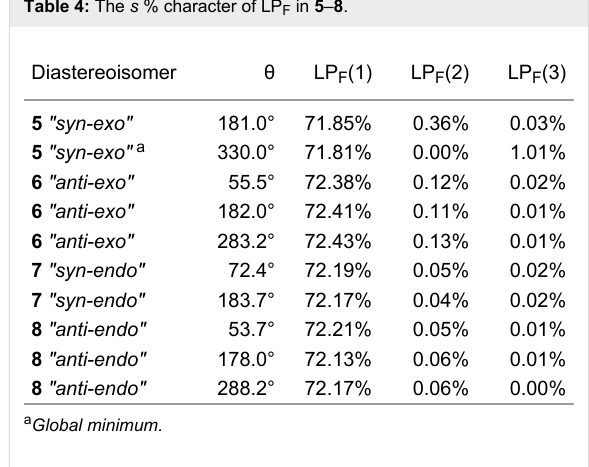
Table 4: The s % character of LP F in 5 – 8